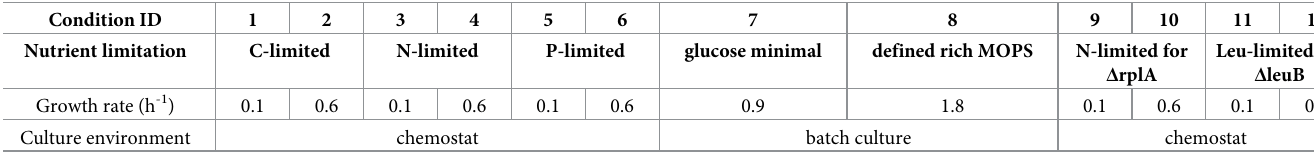
Table 1. List of the 12 different conditions for Escherichia coli in our